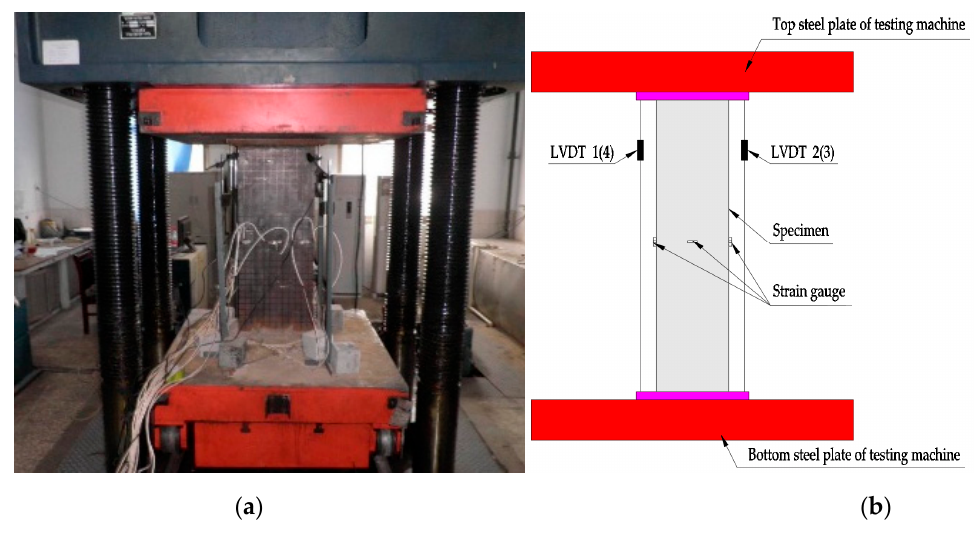
Figure 2. Test setup. ( a ) Photograph; ( b ) diagrammatic view.